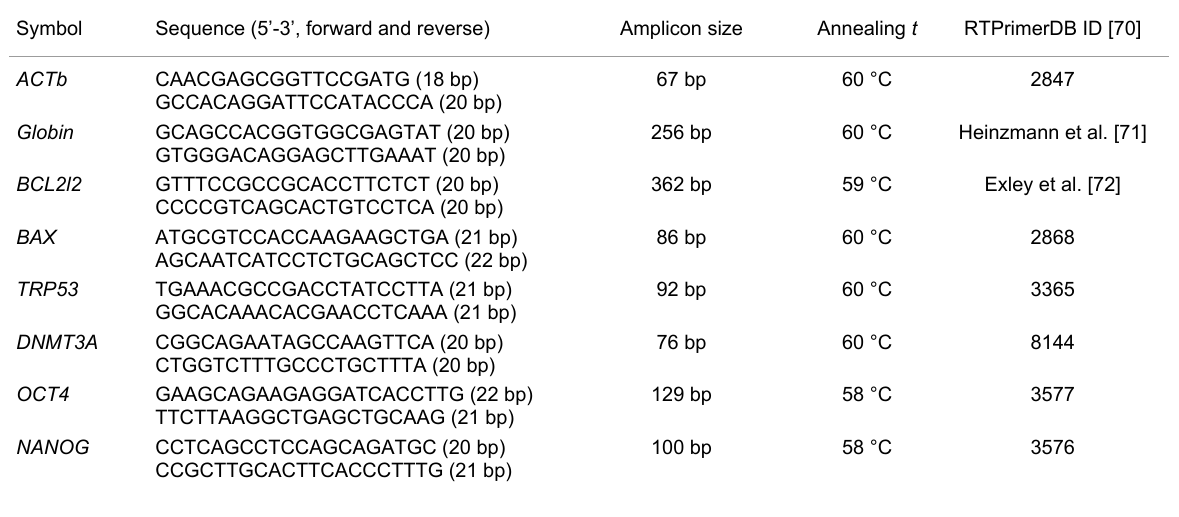
Table 3: Realtime PCR primers and characteristics.